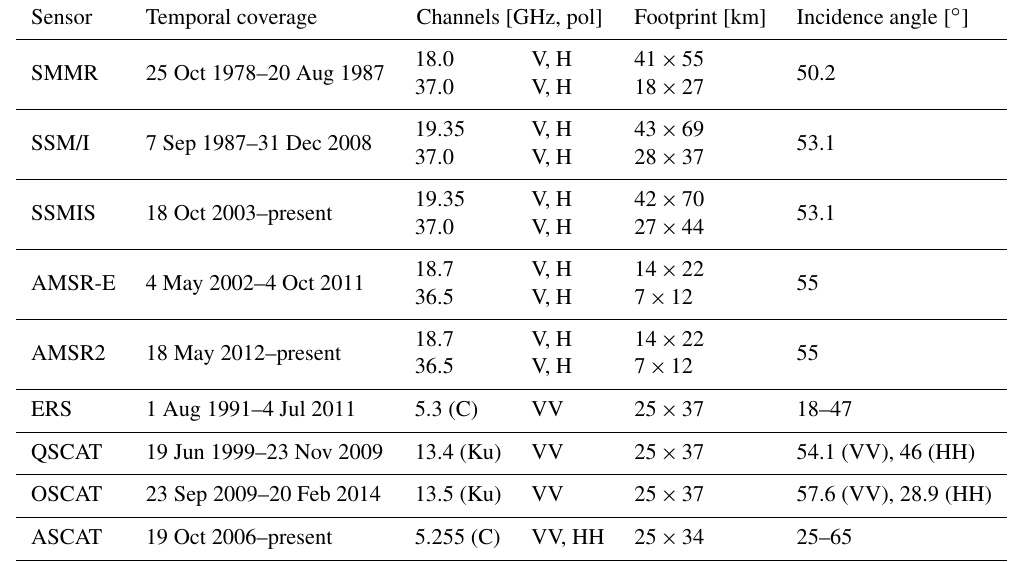
Table A1. Specific information of the different sensors, active periods and channels used in the SITY products.